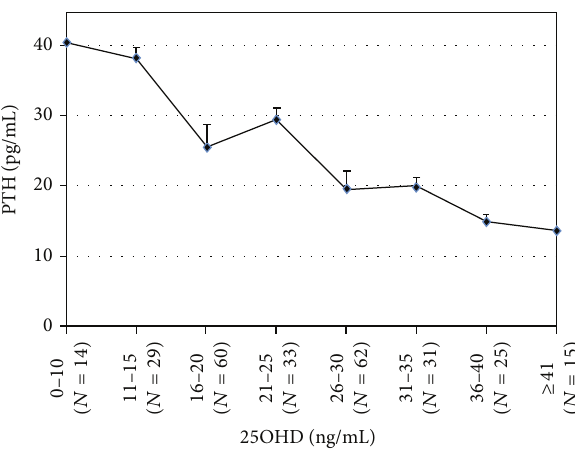
Figure 1: Mean ( ± SE) PTH by 25OHD subgroups. The graph shows subject PTH serum levels according to serum 25OHD subgroups defined by specific cutoffs. No clear inflection point was evident for the 25OHD cutoffs studies. However, there was a 34% increase in PTH levels ( 19.5 ± 1.53 versus 29.5 ± 3.3 pg/mL; 𝑃 = 0.002 ) when comparing the two subgroups delineated by the 25OHD cutoff of 25 ng/mL. PTH levels did not change significantly differently when comparing the subgroups delineated by the 25OHD levels of 20 ng/mL ( 29.5 ± 3.3 versus 25.67 ± 1.51 pg/mL; 𝑃 = 0.228 ), 30 ng/mL ( 19.5 ± 1.53 versus 20.06 ± 2.61 pg/mL; 𝑃 = 0.853 ), 35 ng/mL ( 14.96 ± 1.28 versus 20.06 ± 2.61 pg/mL; 𝑃 = 0.110 ), or 40 ng/mL ( 13.8 ± 1.16 versus 14.96 ± 1.28 pg/mL; 𝑃 = 0.543 ), respectively.